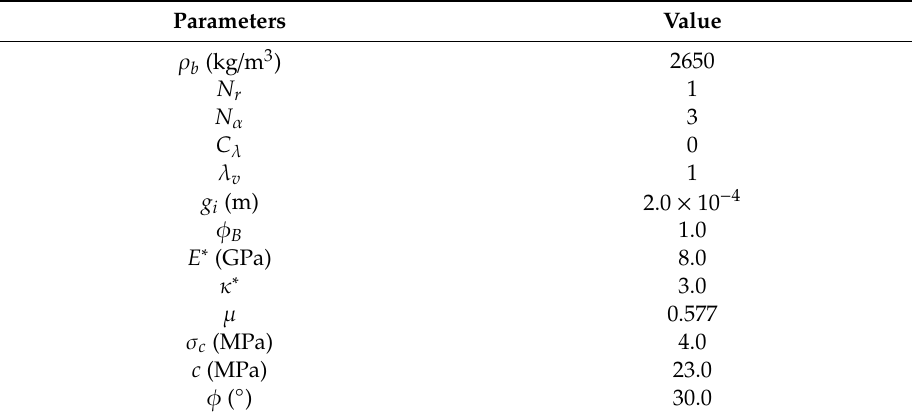
Tabl e 3 . Tested values of micromechanical parameters Parameters